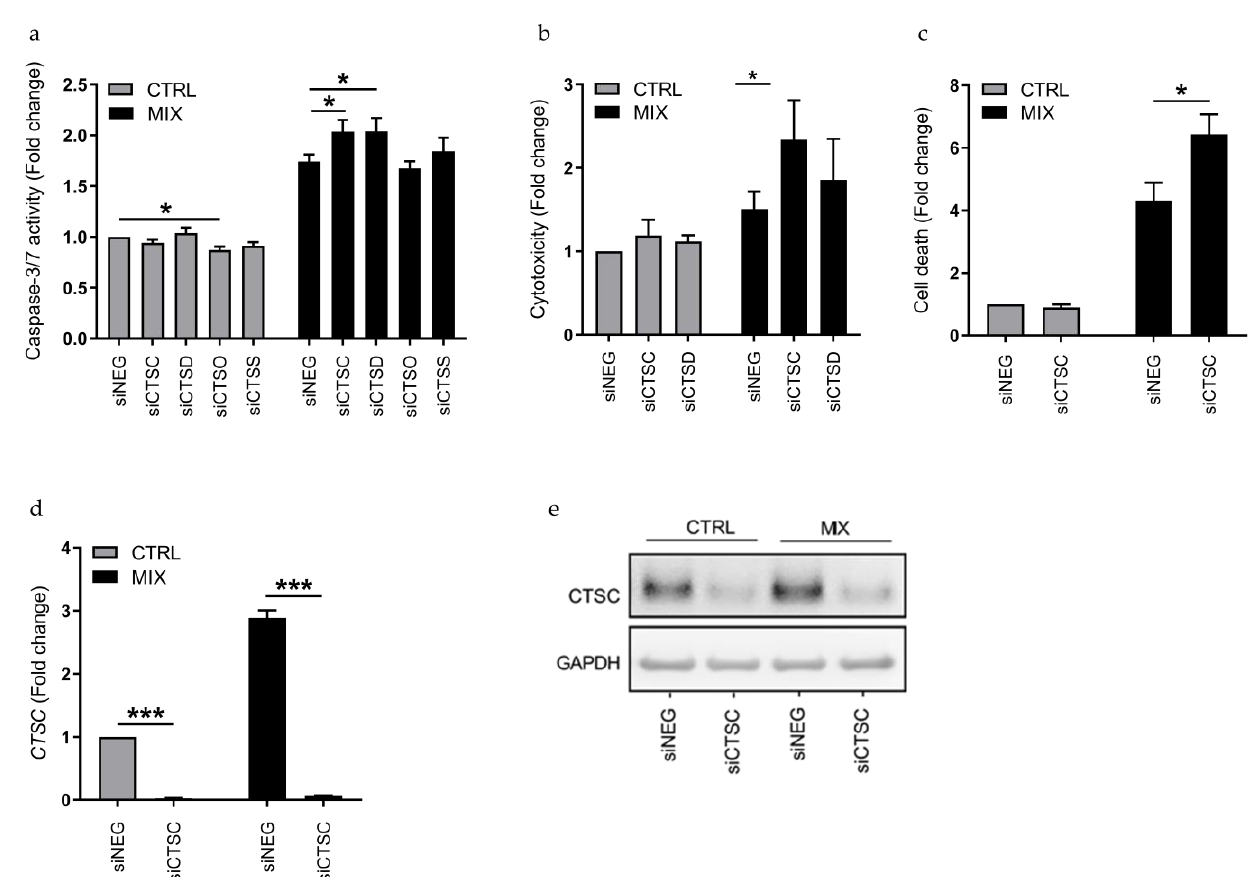
Figure 2. Knockdown of CTSC increases caspase-3/7 activity, cytotoxicity and cell death in 1.1B4 cells. ( a ) Caspase-3/7 activity in 1.1B4 cells transfected with siRNAs against CTSC (siCTSC), CTSD (siCTSD), CTSO (siCTSO), CTSS (siCTSS) or a non-targeting negative control siRNA (siNEG) and left untreated (CTRL) or exposed to IL-1 β , IFN- γ and TNF- α for 24 h (MIX). Caspase-3/7 activities were normalized to total cell content. The data are presented as fold changes with means ± SEM ( n = 6). ( b ) Cytotoxicity in 1.1B4 cells transfected with siCTSC, siCTSD or siNEG and left untreated (CTRL) or exposed to IL-1 β , IFN- γ and TNF- α for 24 h (MIX). Cytotoxicity measurements were normalized to total cell content. The data are presented as fold changes with means ± SEM ( n = 4). ( c ) Cell death in 1.1B4 cells transfected with siCTSC or siNEG and left untreated (CTRL) or exposed to IL-1 β , IFN- γ and TNF- α for 24 h (MIX) as measured by the Cell Death Detection ELISA. Data were normalized to DNA content ( d ) mRNA expression of CTSC in 1.1B4 cells treated as in (c), analyzed by real-time qPCR and normalized to GAPDH . Data are presented as fold changes with means ± SEM ( n = 4). ( e ) Protein level of CTSC in 1.1B4 cells treated as in ( c ), analyzed by immunoblotting with GAPDH as loading control. *: p < 0.05; **: p < 0.01; ***: p < 0.001.